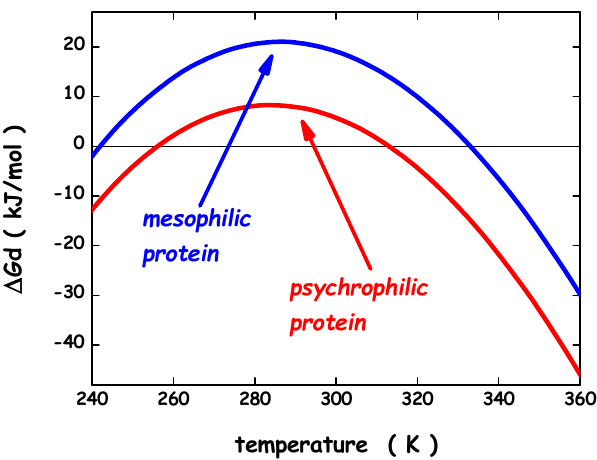
Figure 3. Thermodynamic stability curves for a model psychrophilic protein and a model mesophilic one. See text for further details.